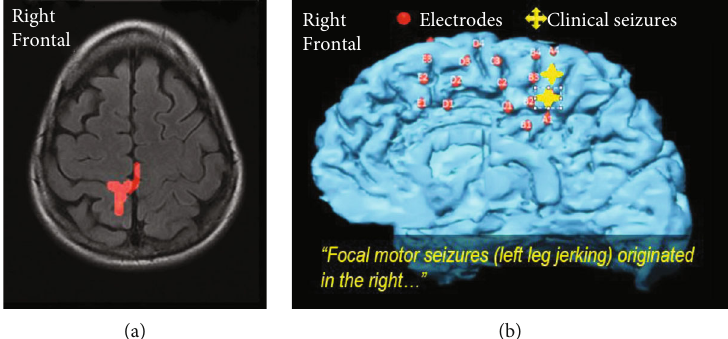
Figure 4: An illustrative example of a patient with distinct brief focal motor seizures involving the left leg without an EEG correlate and with a normal three tesla MRI with epilepsy protocol. SISCOM at two standard deviations (a) matched intracranial monitoring with cortical mapping (b). (a) A SISCOM (Injection latency of 6 seconds during a 14-second habitual clinical seizure without scalp EEG correlate) revealed increased uptake in the right paracentral region (leg area). (b) Cortical mapping identi fi ed the left leg motor activity in the area of seizure onset. A typical electroclinical seizure was produced by stimulation in the same region. The patient underwent responsive neurostimulation (RNS) implant leading to 100% seizure